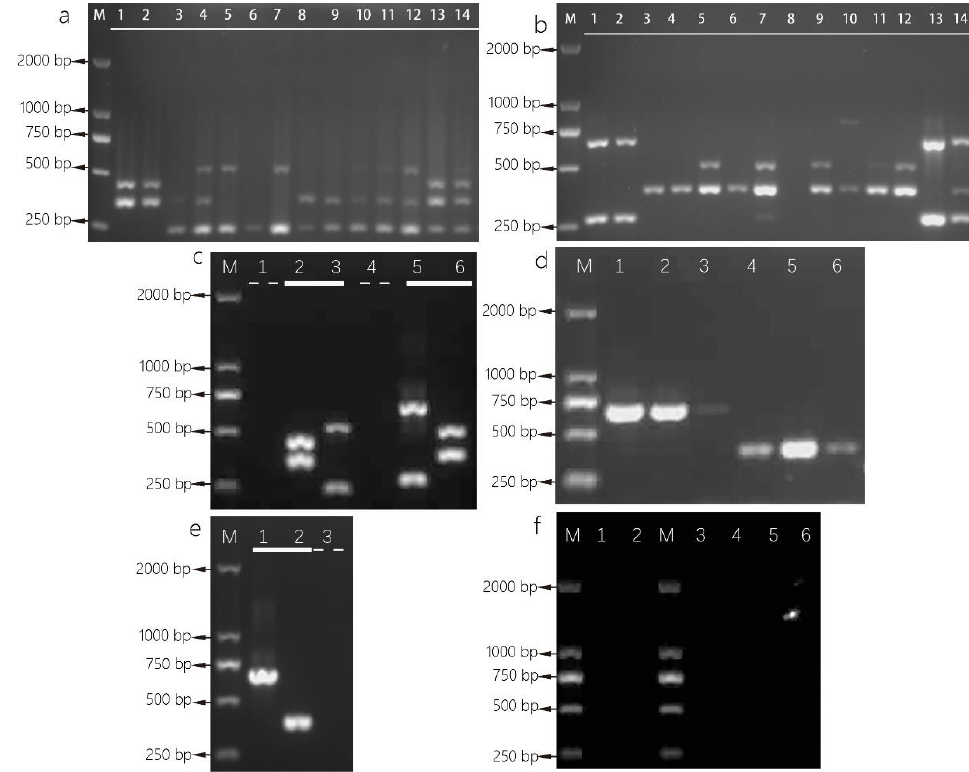
Figure 4. Multiplex PCR of Aspergillus strains. ( a ) Primer set 1 mixed aOP2, aOP3, iOP1 and iOP3;